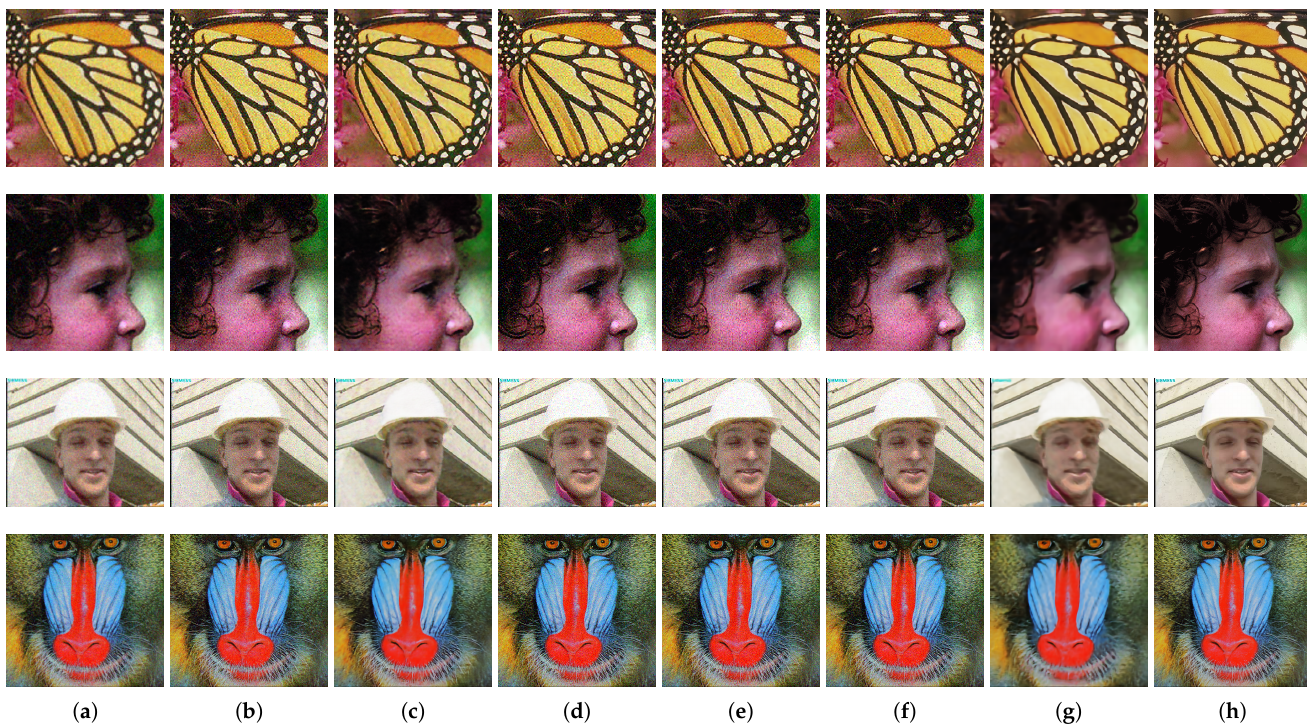
Figure 3. Qualitative comparisons of Set5 [11] and Set14 [12] ( × 2, σ = 15). ( a ) Bicubic, ( b ) DIP-SR [1], ( c ) DIP-Seq, ( d ) DRLN [22],